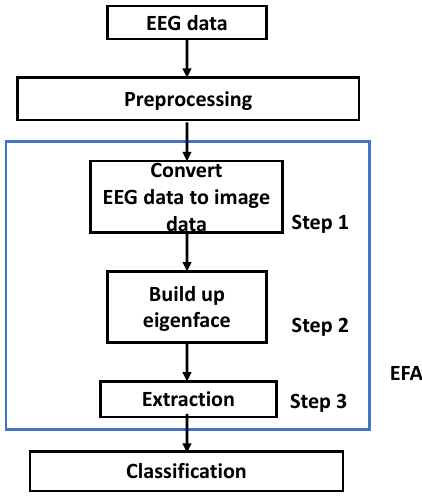
Figure 3. The EFA algorithm procedure.